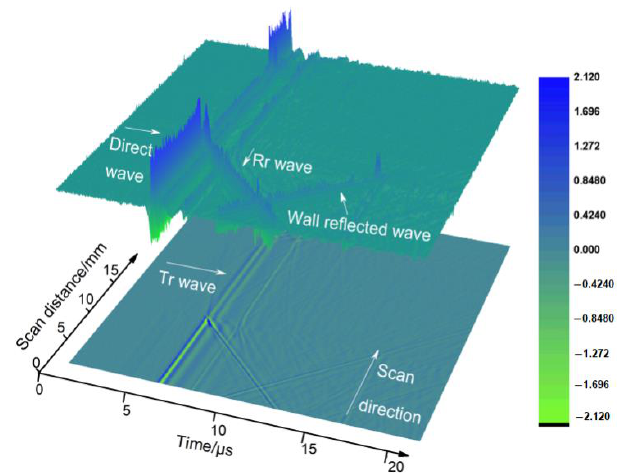
Figure 21. Three- and two-dimensional plots of the B-Scan image of oblique cracks (angle = 60°, depth = 0.5 mm).